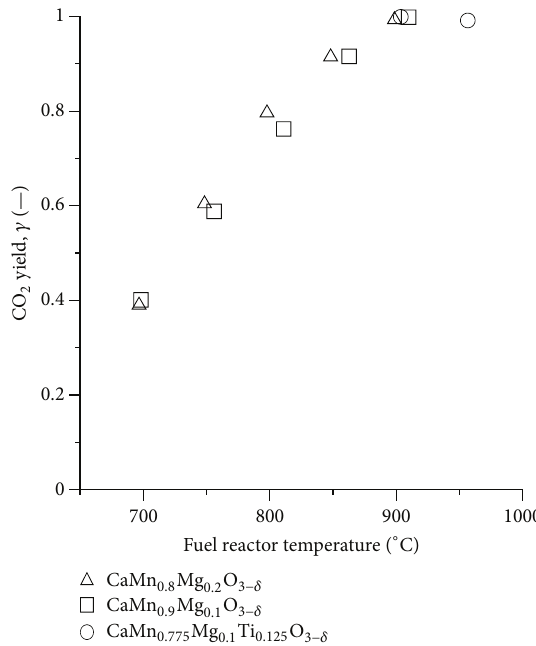
Figure 5: Effect of temperature on combustion efficiency for the used materials. The plotted values are averages for 15min operation was 0.3 L N min −1 except for the point at at each temperature. 𝐹 FR , ng 𝑇 = 950 ∘ C where 𝐹 was 0.4 L N min −1 . 𝐹 was 6L N min −1 . FR , ng AR , air